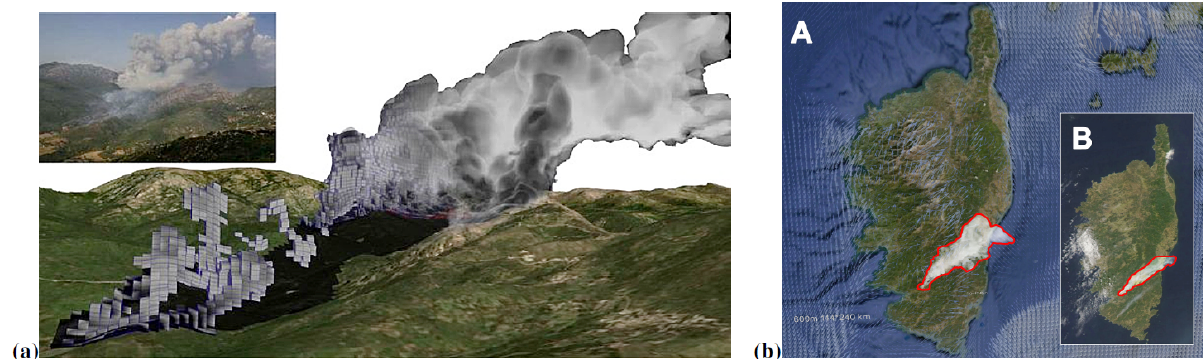
Figure 12. Simulated smoke tracer on 23 July 2009 (a) in the 50m resolution domain compared to the plume’s photograph (at the top left) and (b) in the 600m resolution domain highlighted in red (A) at 15:00UTC compared to the MODIS image (B) of Corsica at 14:50UTC.